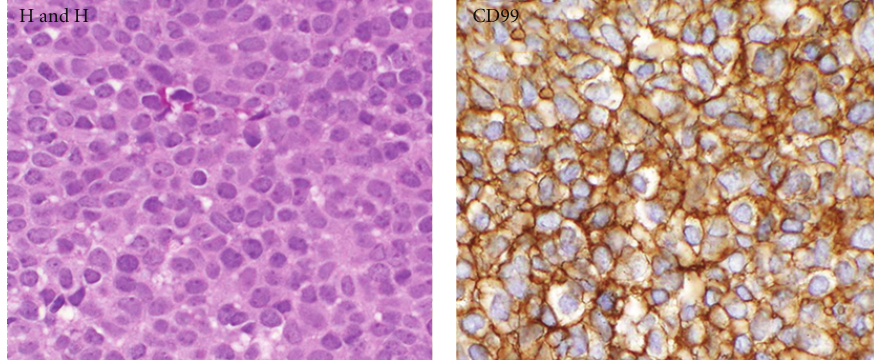
Figure 3: Histopathological images revealing the typical aspect of a densely cellular “blue tumor” composed of small round cells uniformly arranged in sheets and with strong membranous CD99 immunoreactivity (H&H stain × 20, CD99 immunohistochemical stain ×